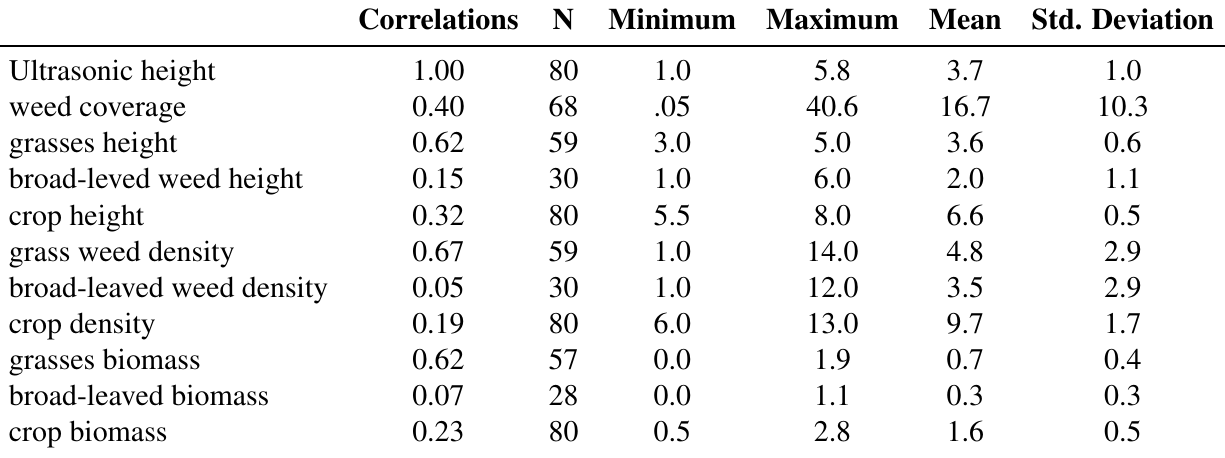
Table 1. Descriptive statistics for the variables of the study (in cm). Correlations were computed for ultrasonic heights and N is the number of